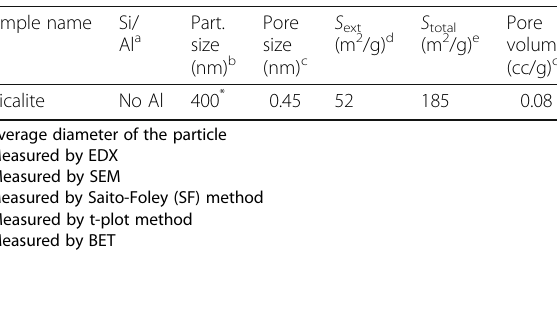
Table 1 Characteristics of